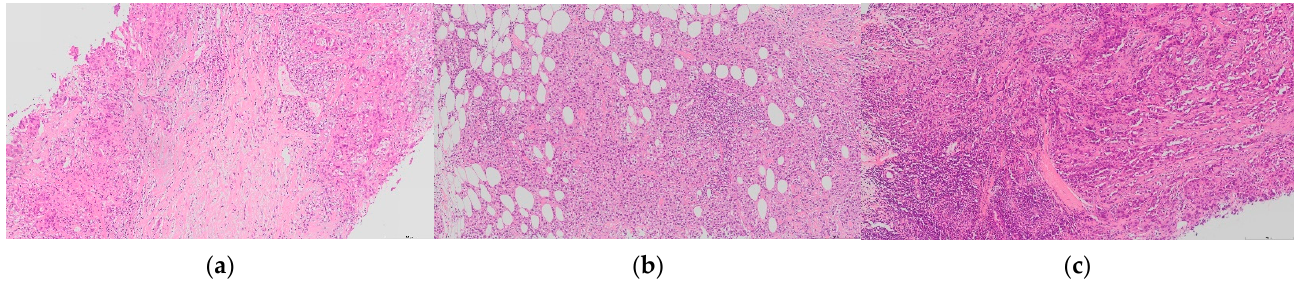
Figure 4. H&E images of sTILs heterogeneity in TNBC. Sparse sTILs within stroma between tumour with more dense